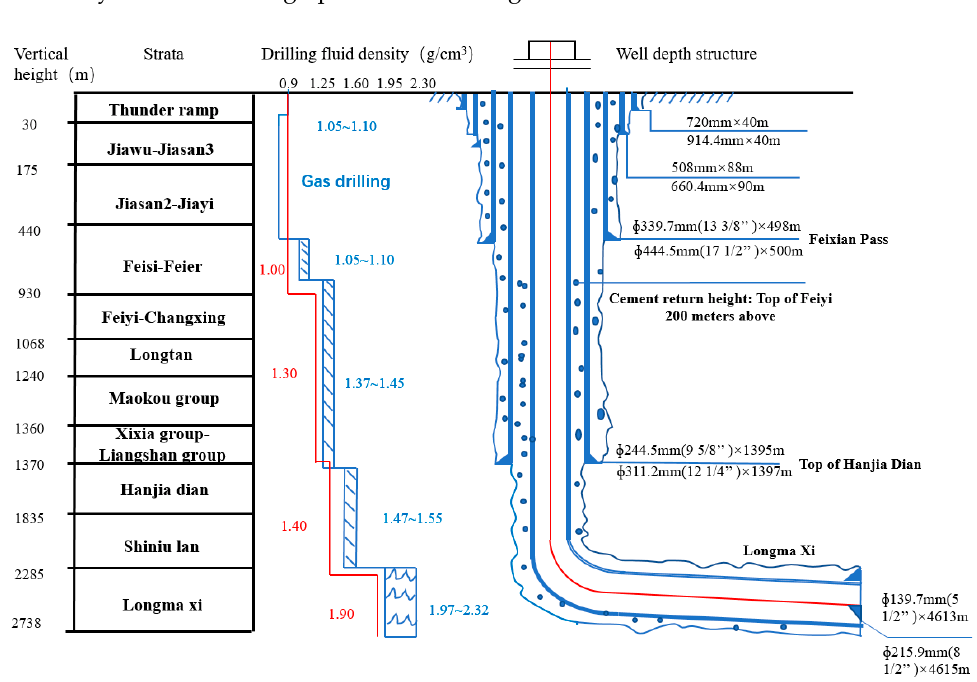
Figure 5. Chart of casing program of Well